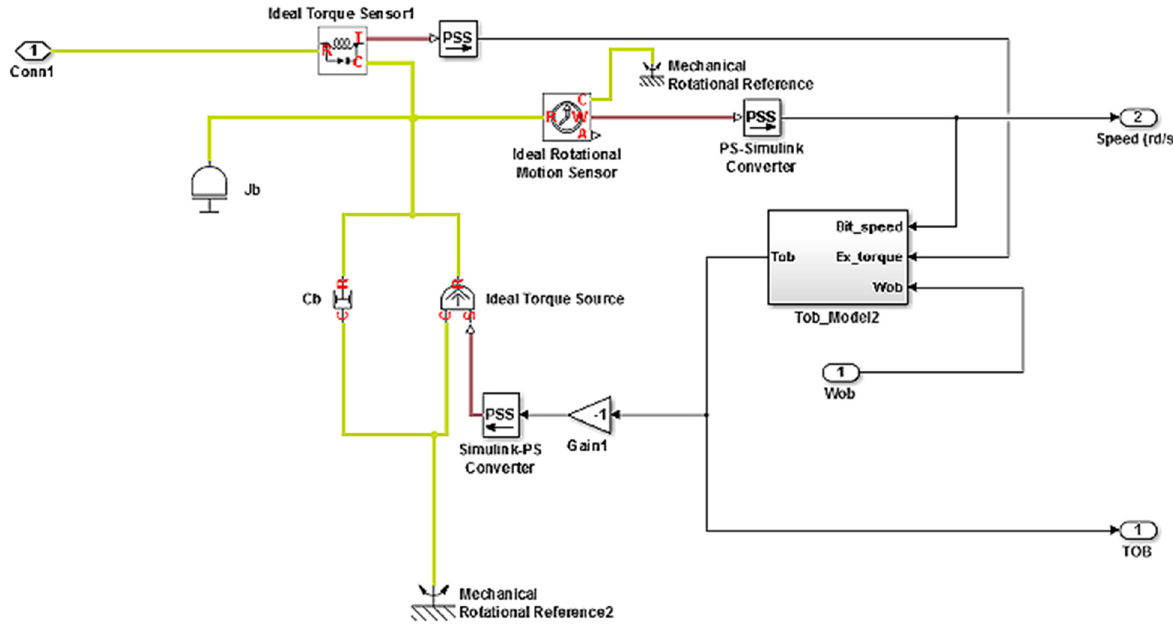
Figure 2. Rock–bit interaction block in SimScape environment [24].